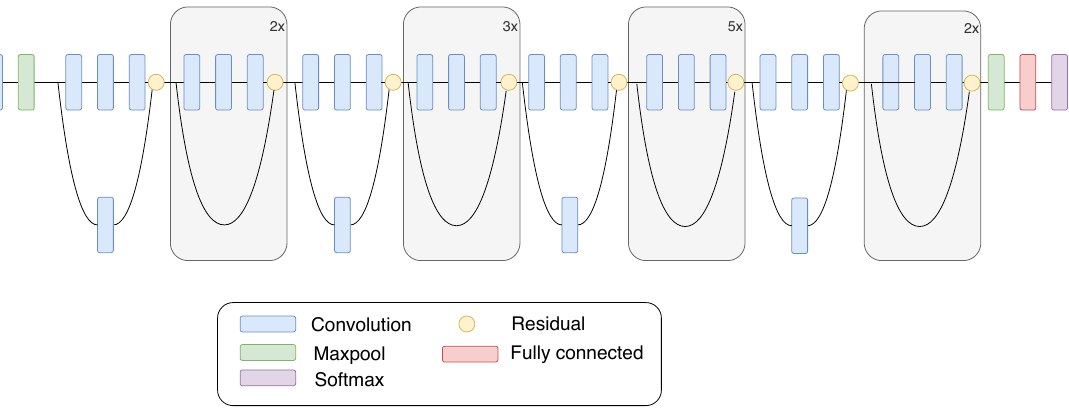
Figure 7. ResNet architecture